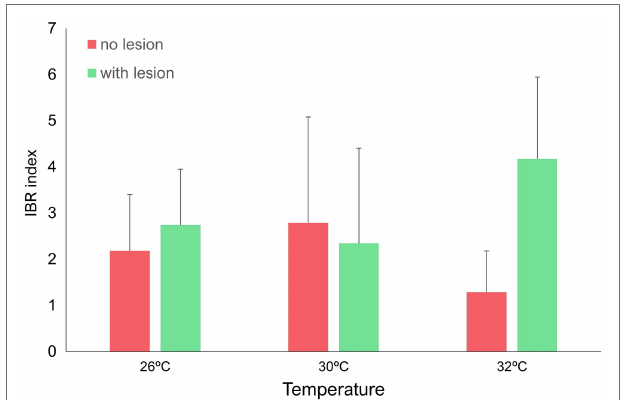
FIGURE 7 | IBR (Integrated Biomarker Response) index (mean + sd of the seven coral species) for all temperatures tested (26, 30, and 32 ° C) under different predation treatments (no lesion vs. with wound lesion in coral